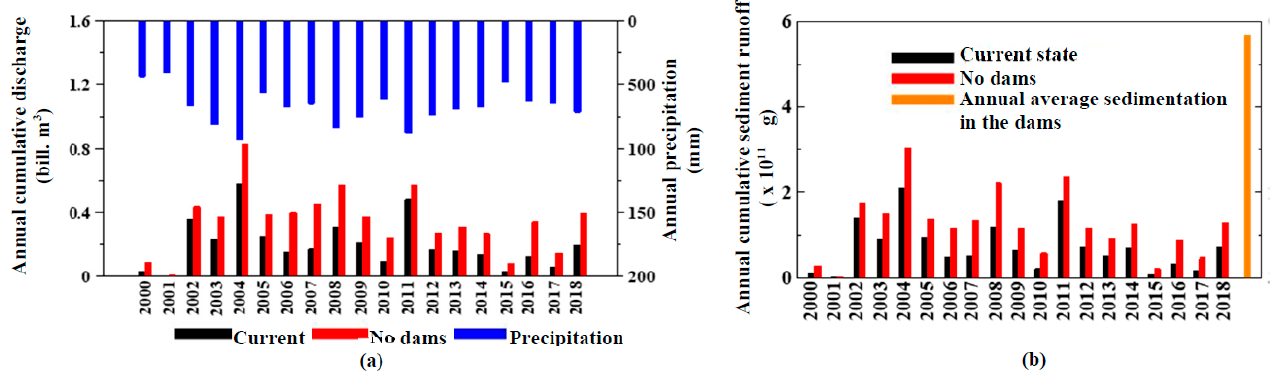
Figure 25. Comparison between the cases with/without dams: ( a ) Annual cumulative discharge and ( b ) Annual cumulative sediment runoff.